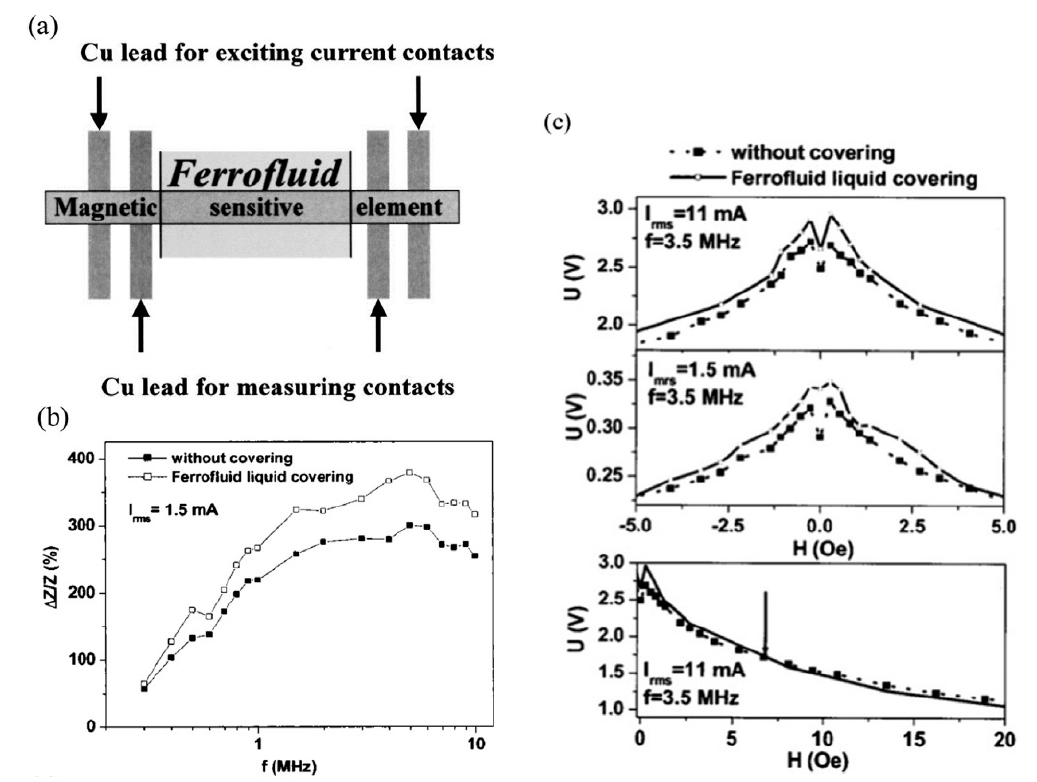
Figure 6. Detection of magnetic ferrofluid. ( a ) MI biosensor schematic using test setup. ( b ) MI effect based on Frequency. ( c ) MI effect based on magnetic field when covering the sensing element and when uncovering. Reprinted from [102], with the permission of AIP Publishing.